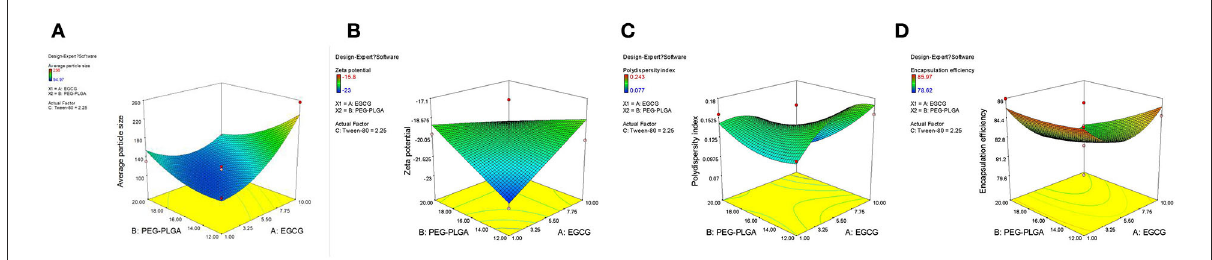
FIGURE1 3D surface of the effect of EGCG-NPs. (A) Zav surface response at a fixed EGCG concentration of 1.5 mg/ml. (B) ZP response at a fixed Tween-80 concentration of 2.25%. (C) PDI response. (D) EE response at a fixed Tween-80 concentration of